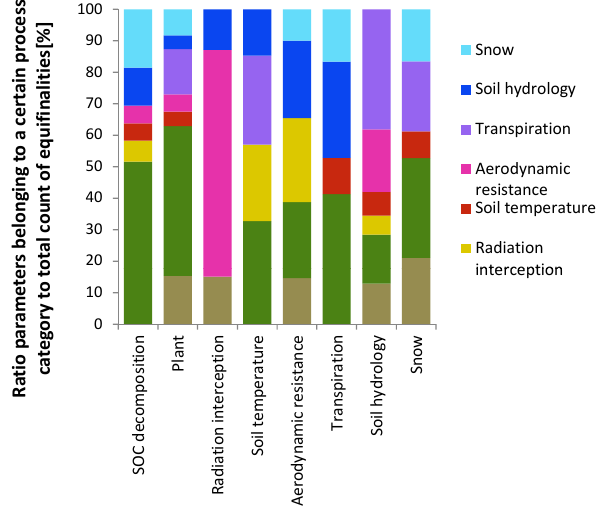
Figure 7. Process category belonging to parameters that correlated with parameters of a certain process